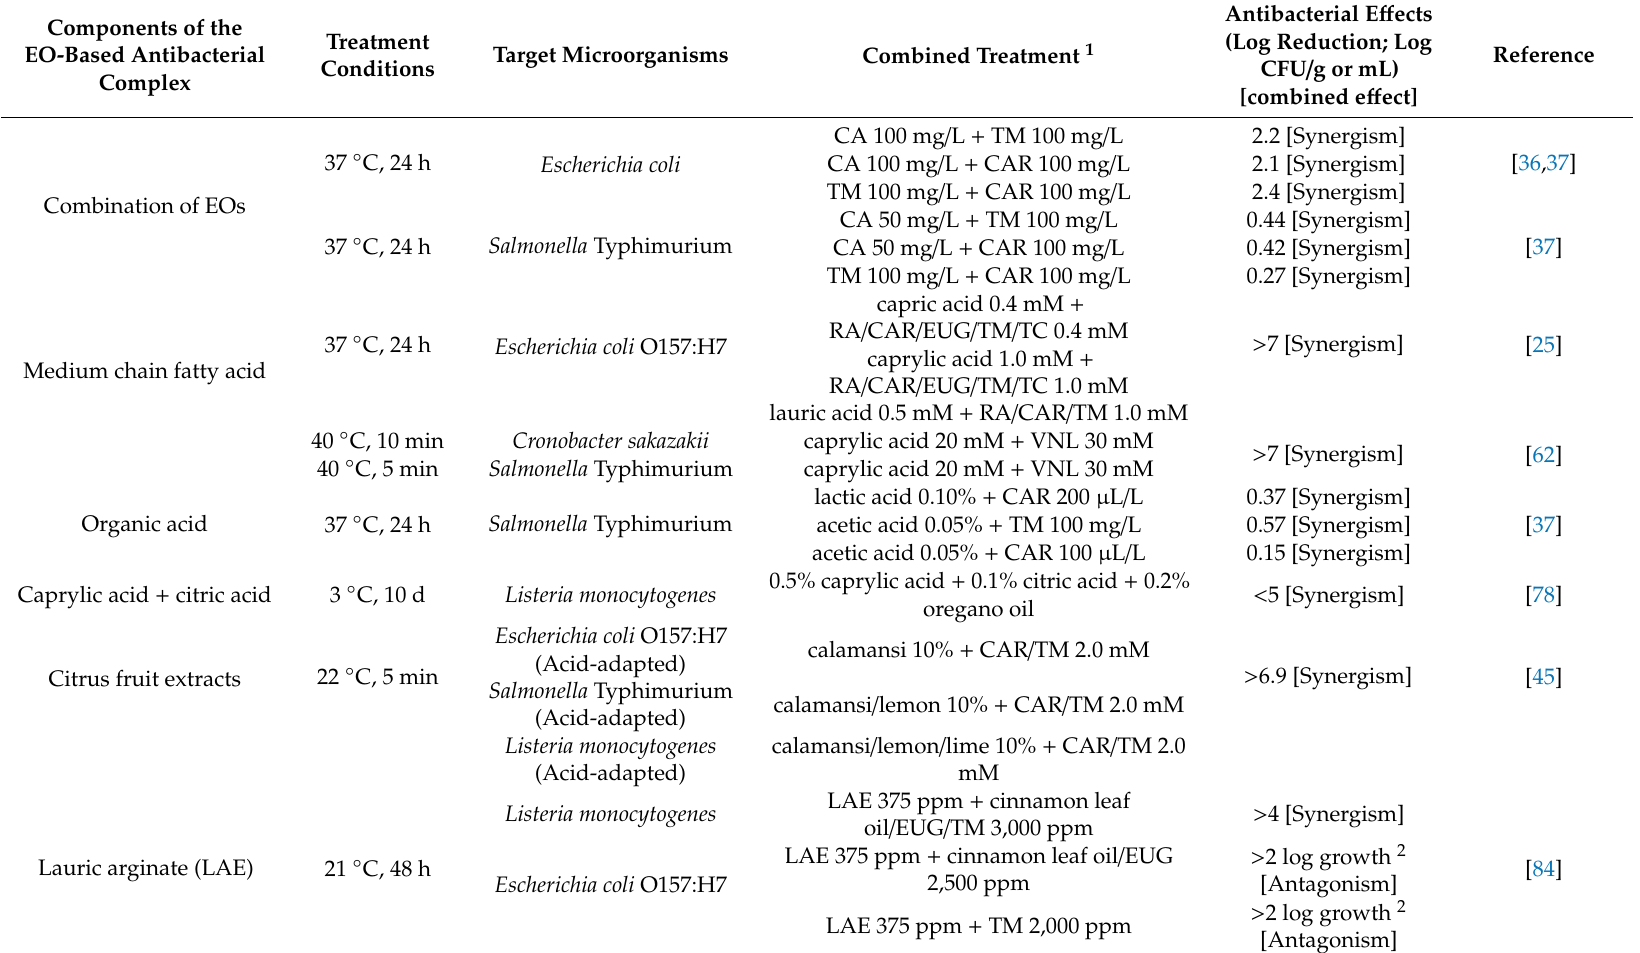
Table 4. E ffi cacy of combined treatment of essential oils as antibacterial